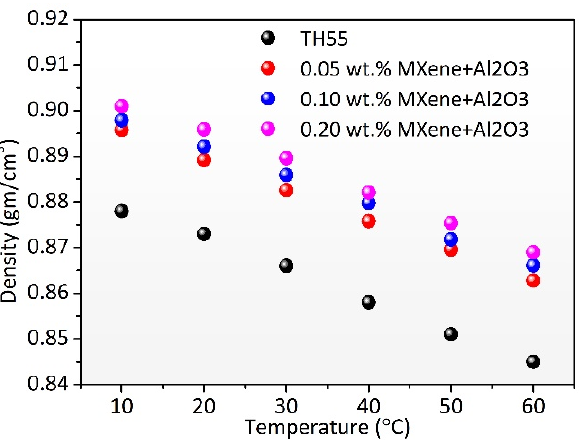
Figure 10. Density of TH-55/MXene + Al 2 O 3 nanofluids with respect to varying temperature and particle concentrations.